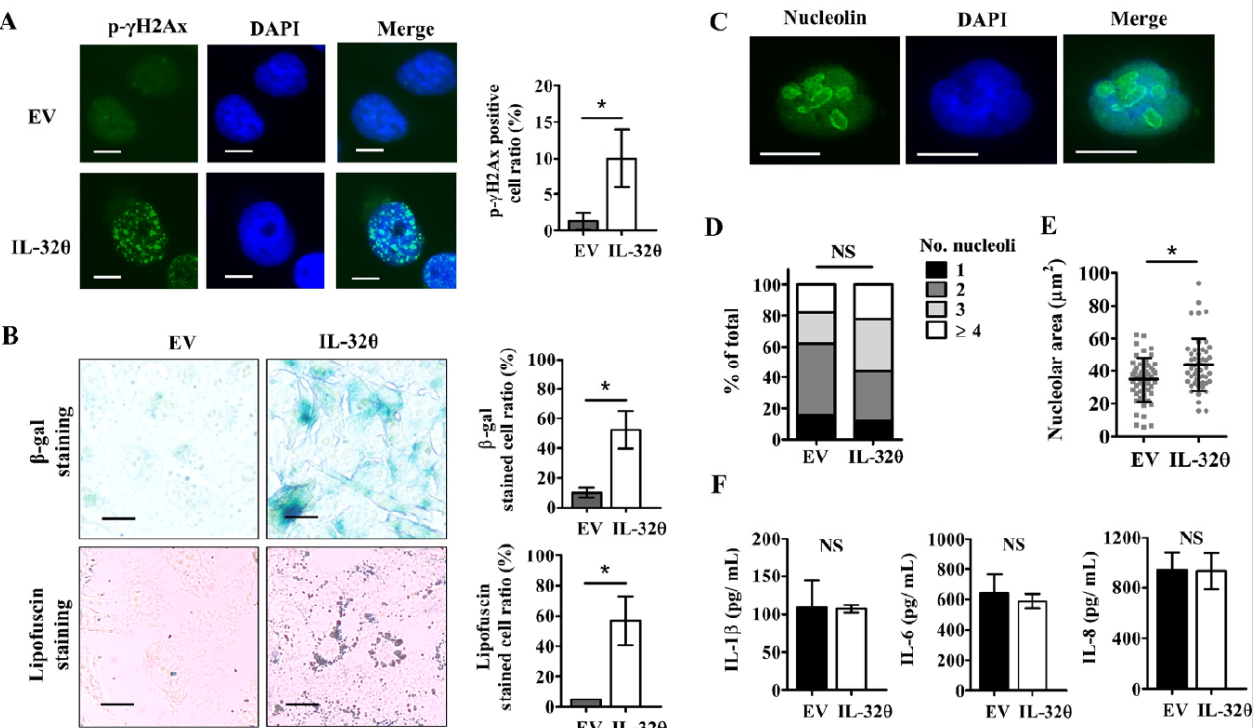
Figure 2. Interleukin-32 θ induces senescence in breast cancer cells. ( A ) Immunofluorescence assay to detect p- γ H2Ax positive cells (green). Nuclei were stained with DAPI (blue). Scale bar, 20 µ m. ( B ) Ratios of cells stained with SA- β -gal or lipofuscin assessed by microscopy. Scale bar, 20 µ m. ( C ) Immunofluorescence assays of nucleoli (green) with boundaries in individual nuclei determined using anti-nucleolin antibody. Scale bar, 10 µ m. ( D ) Ratios (%) of total nucleoli per cell ( E ) Total area ( µ m 2 ) of nucleoli per cell. ( F ) Secreted IL-1 β , IL-6, and IL-8 measured by ELISA. * p < 0.05 (Student t -tests). Nucleoli were counted using Fiji software. Results are representative of three independent experiments. NS, not